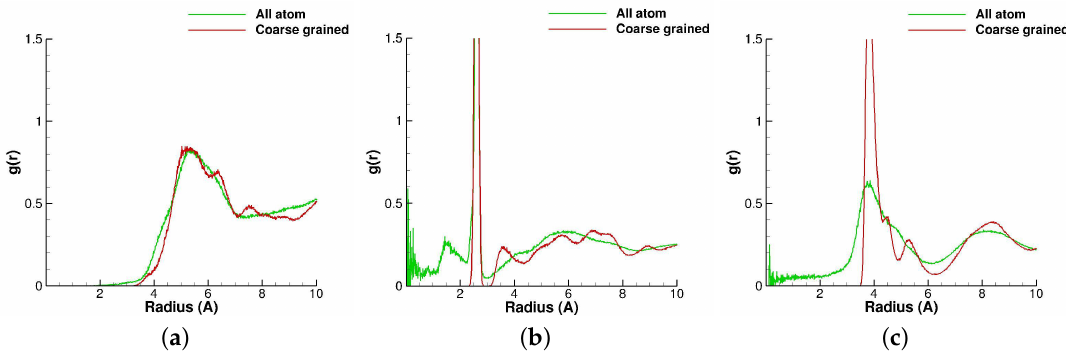
Figure 4. Radial density function (RDF) comparison between all-atom and coarse-grained simulation of EAN for different sites. ( a ) Site E1-E1; ( b ) Sites E2-N1; ( c ) Site